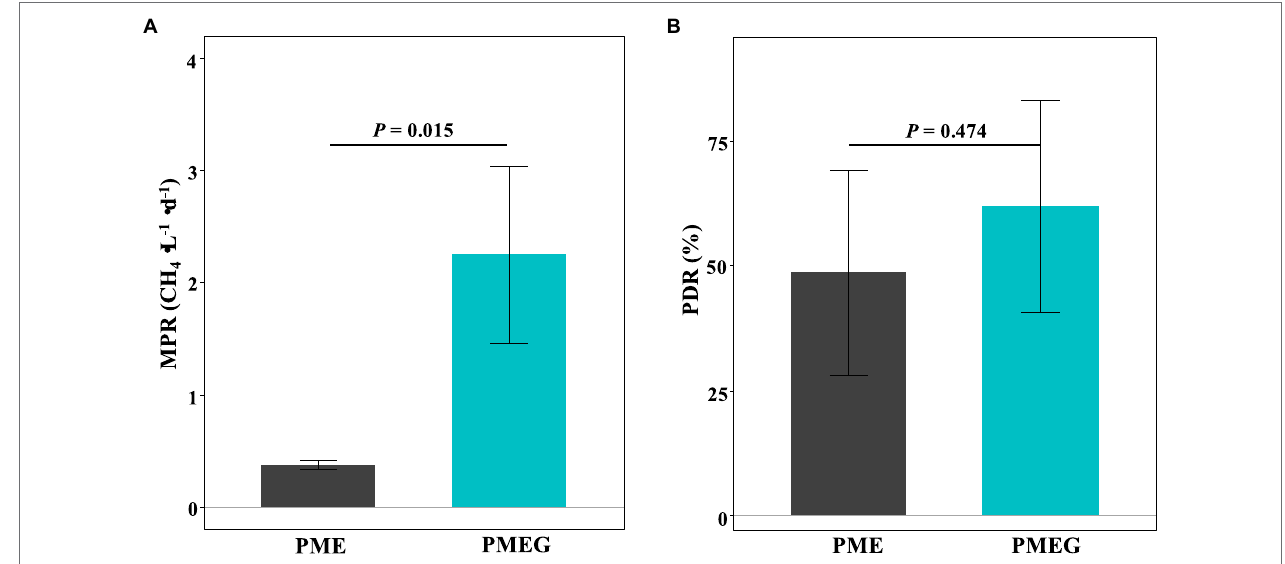
FIGURE 3 | The MPR (A) and PDR (B) in the enriched consortium treatments of without (PME) and with (PMEG) additon of glucose. Error bars indicate SDs ( n = 3). The p values above the horizontal lines are the results of independent t